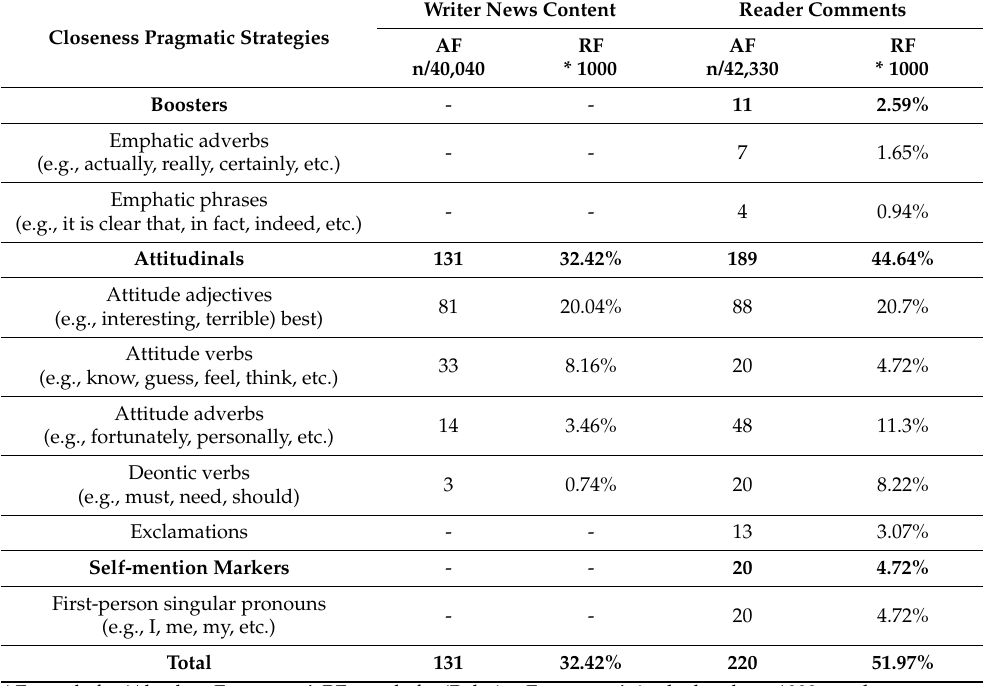
Table 2. Frequencies in the use of closeness pragmatic strategies in the two